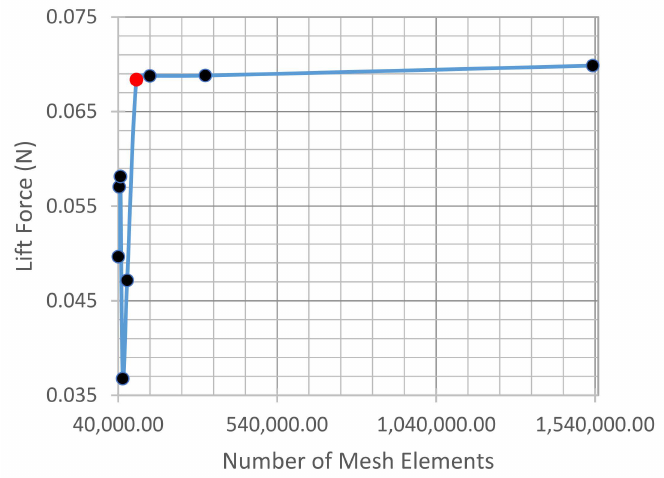
Figure 16. 3D Model and Dimensioned Drawing of Optimal